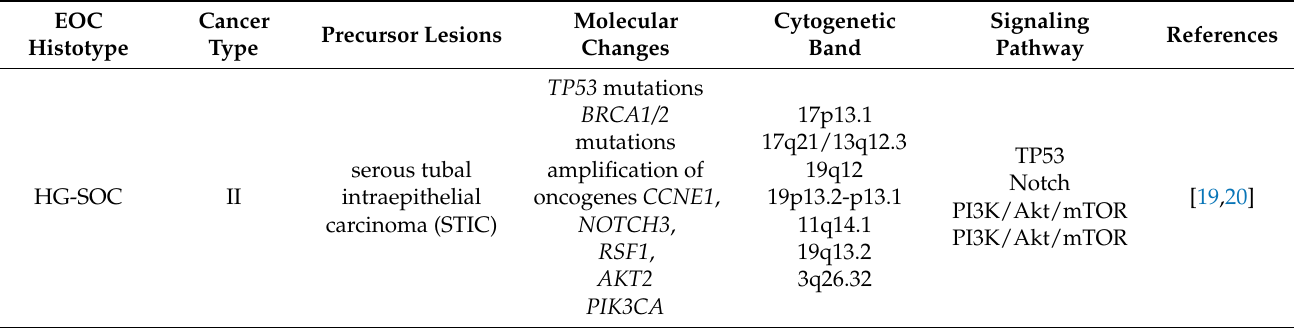
Table 1. A molecular characteristic of the main histotypes of epithelial ovarian